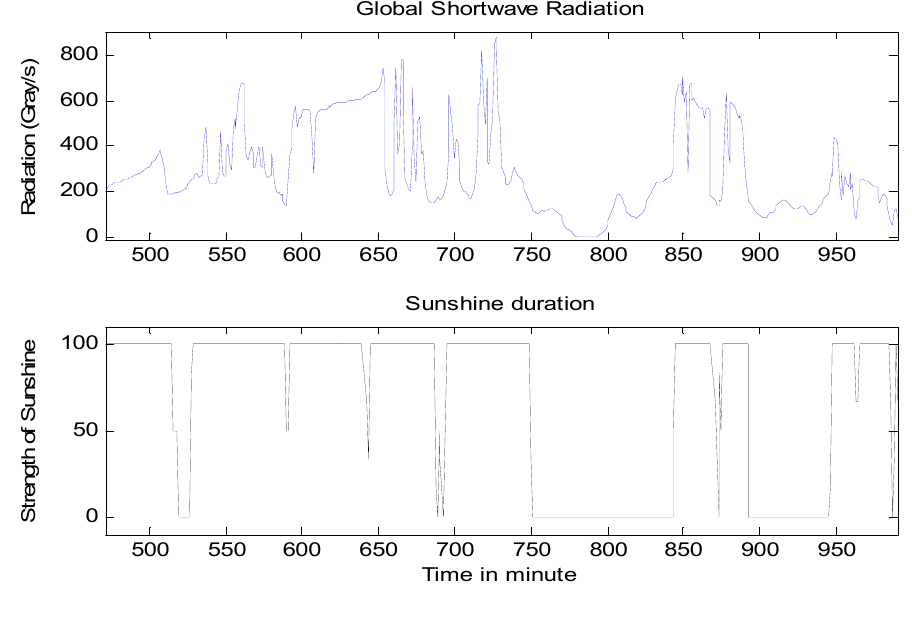
Figure 2. Relationship between sunshine presence and the amount of global shortwave radiation. Top: the amount of global shortwave radiation along the time. Bottom: the sunshine strength along the